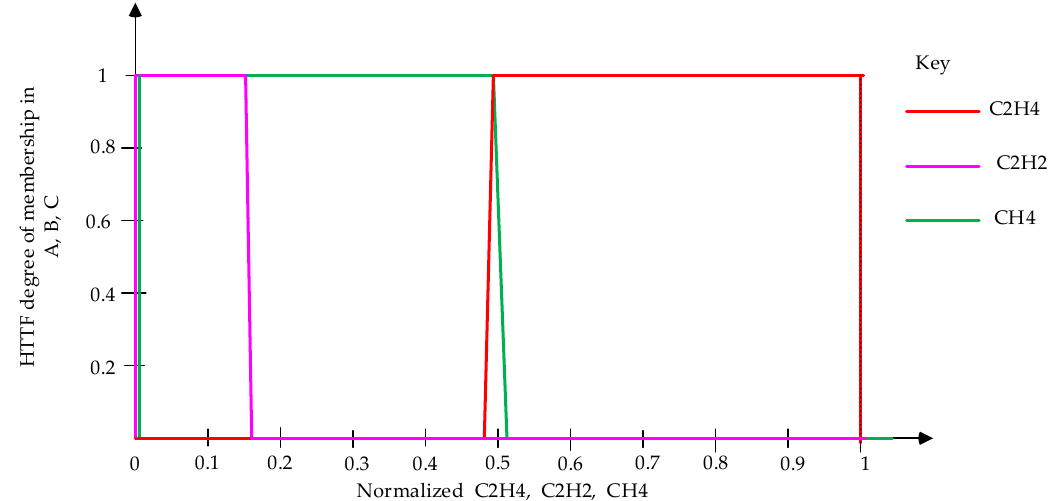
Figure 6. Fuzzy characteristic curves for evaluating an occurrence of high-temperature thermal faults (HTTF).